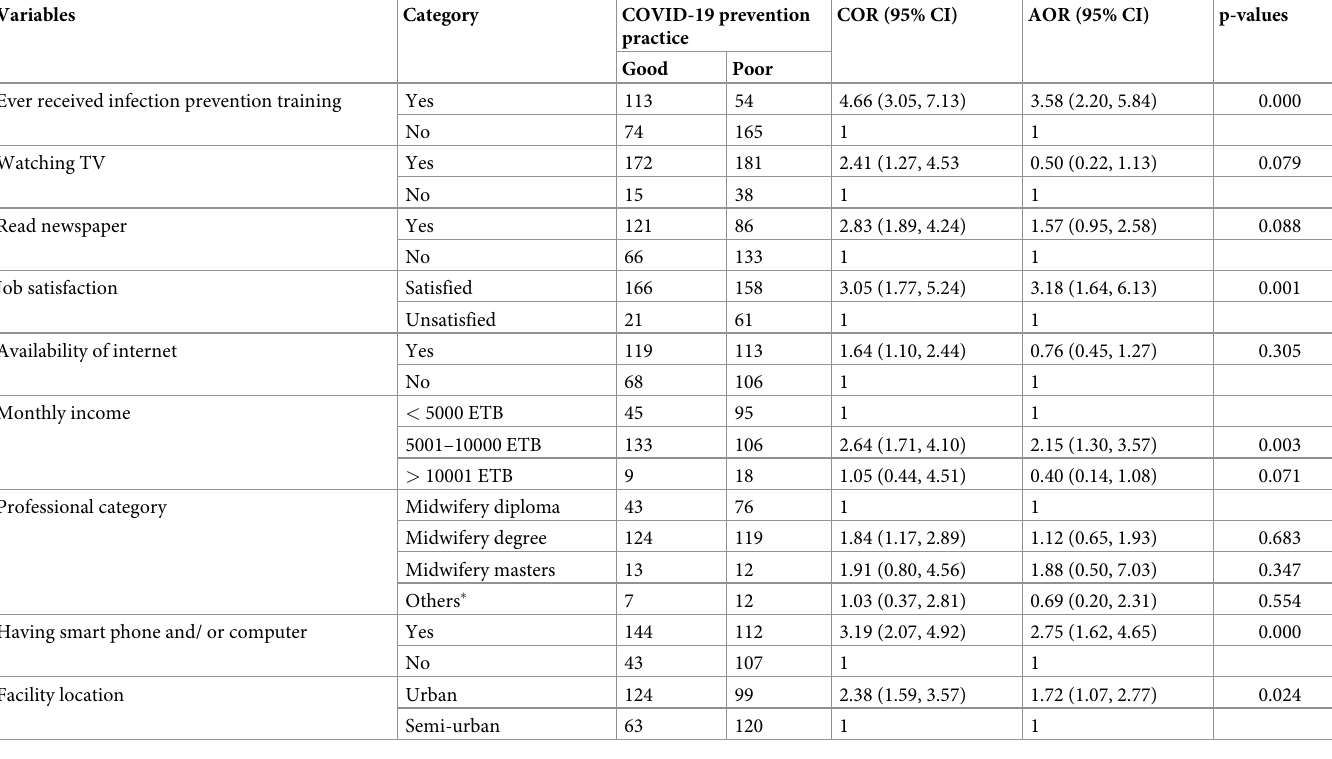
Table 4. Bi-variable and multivariable logistic regression analysis of factors associated with healthcare provider’s adherence to COVID-19 prevention practices in hospitals of Gondar province, northwest Ethiopia, 2020/2021 (n =